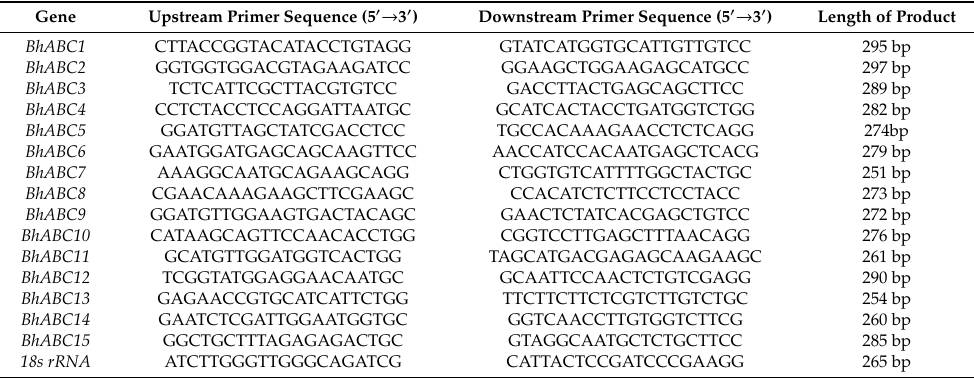
Table 1. Primer sequences of BhABC1 – BhABC15 genes and internal reference gene 18s RNA . Gene Upstream Primer Sequence (5 (cid:48) → 3 (cid:48) ) Downstream Primer Sequence (5 (cid:48) → 3 (cid:48) ) Length of